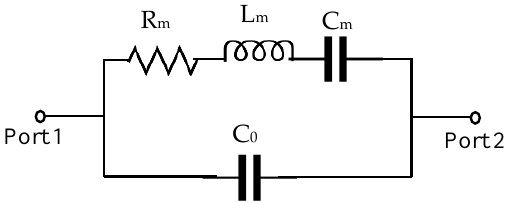
Figure 2. Butterwoth-Vandyke (BVD) Equivalent circuit of FBAR. The Butterworth Vandyke model consist of a series motional resonator ( R m ), mo- tional inductance ( L m ), motional capacitance ( C m ) and parallel static capacitance ( C 0 ). The equivalent circuit parameters can be determined using the following